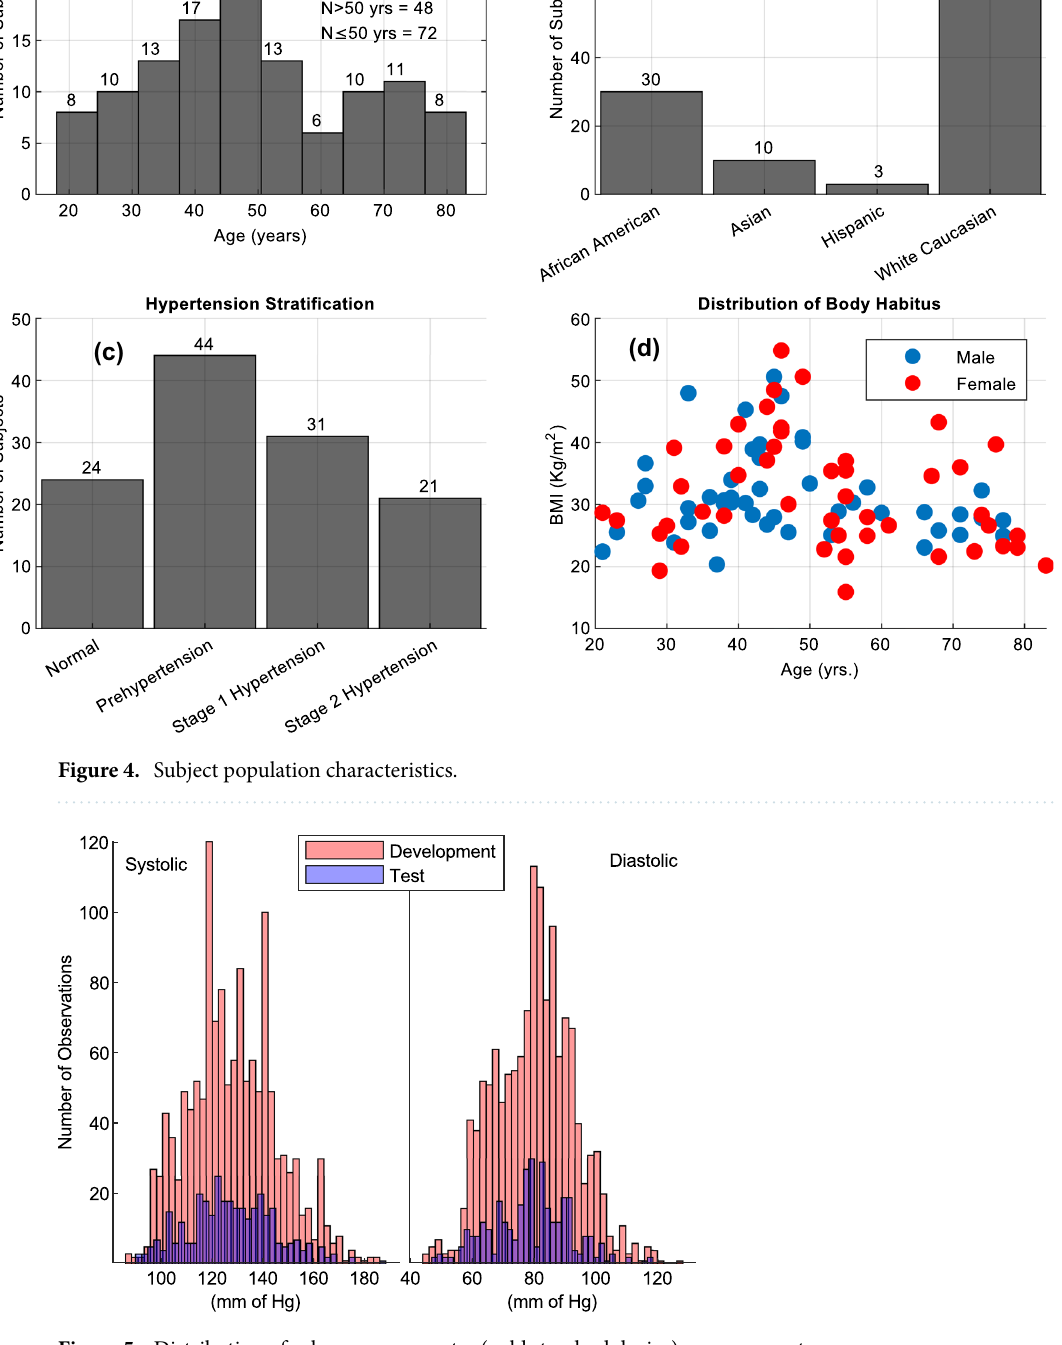
Figure 5. Distribution of sphygmomanometer (gold standard device)